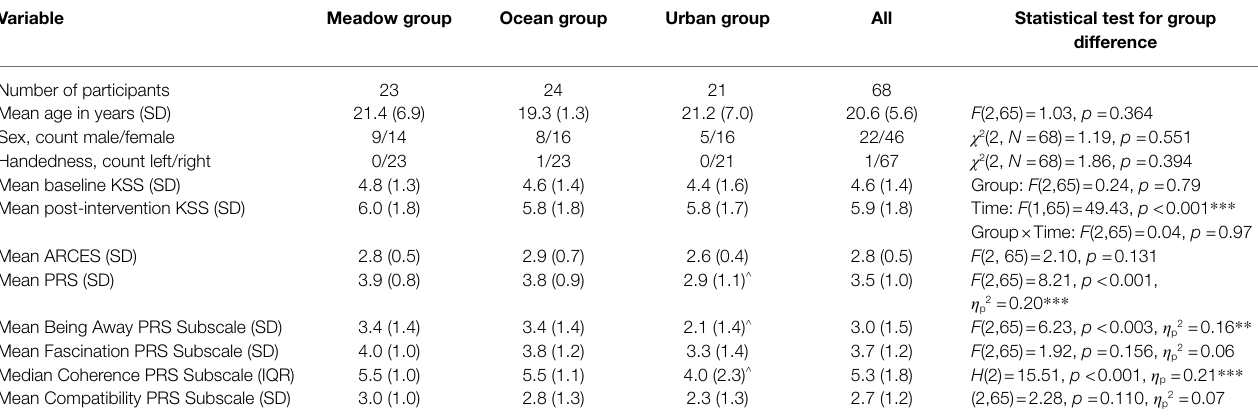
TABLE 1 | Descriptive statistics for participants’ demographic, KSS, ARCES, and PRS scores by Group, for Study 1.